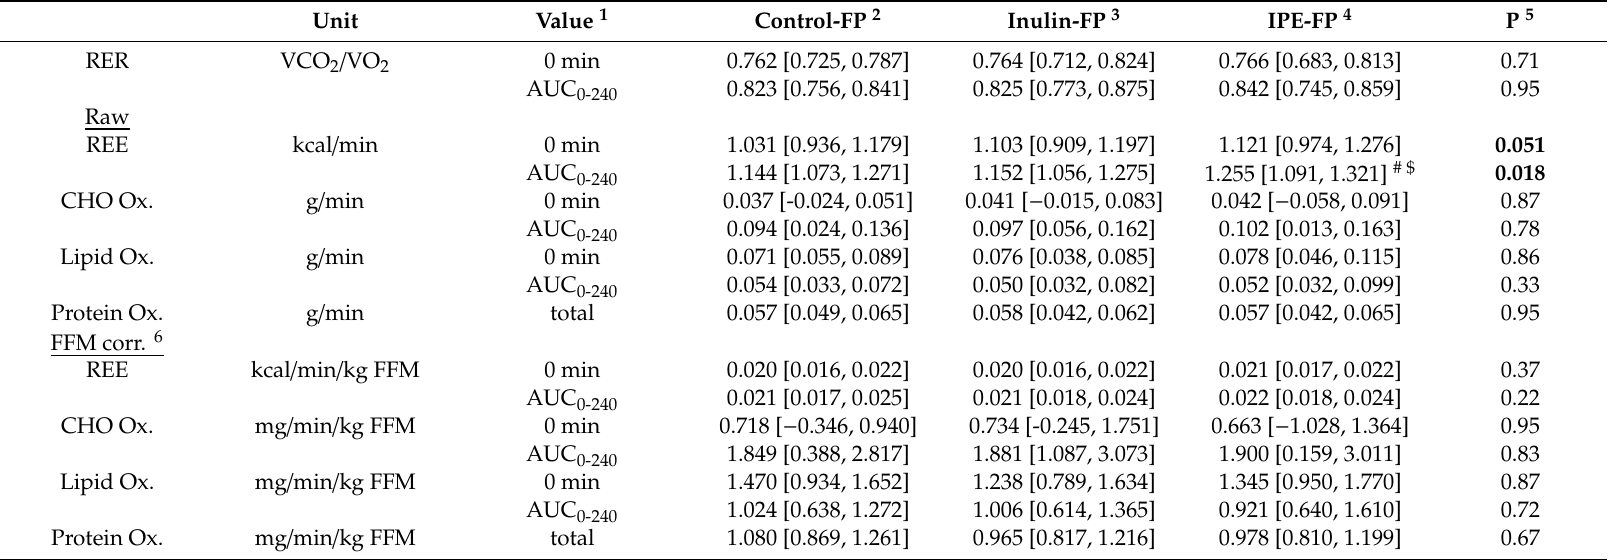
Table 4. Fasting values and AUC for energy expenditure and substrate oxidation, and after correcting for fat-free mass, following a seven-day supplementation with inulin-FP or IPE-FP compared to